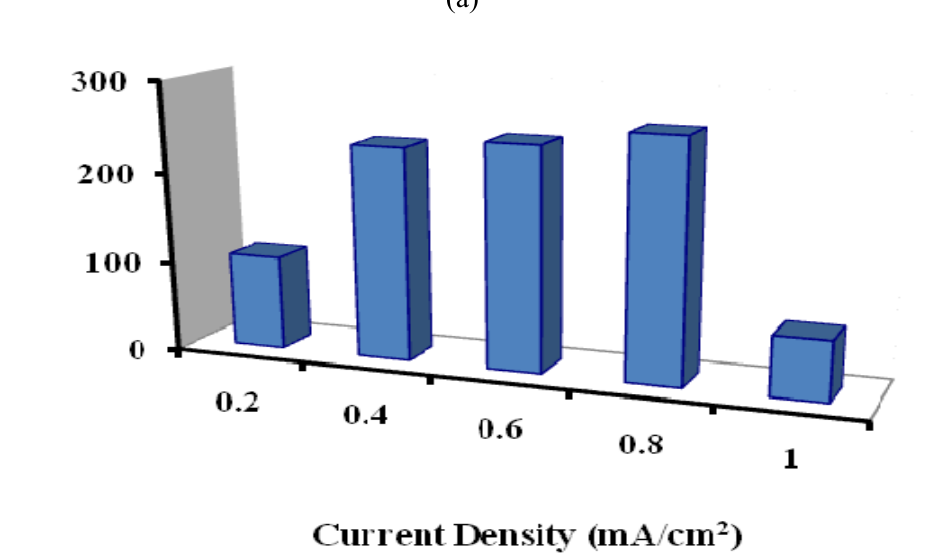
Figure 6. Effect of (a) applied current density and (b) polymerization time used for formation of PTy-PNCnase film on sensitivity of penicillin potentiometric response. Film formation conditions were as for Figure 5, except that for: (a) 3 mM penicillin and 0.01 M were used, while the applied current density was varied; (b) same as (a) but an KNO 3 applied current of 0.8 mA/cm 2 was used and the polymerization time was